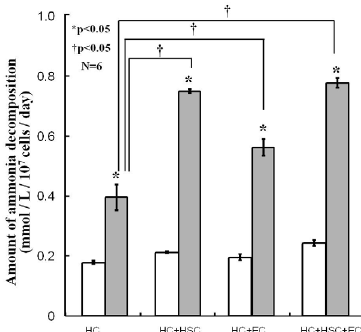
Fig. 4 Amount of ammonia decomposition under flow load. Ammonia decomposition was measured as in Figure 3. White bars, static culture; gray bars, flow load. All models showed significant differences under flow load relative to static culture. Nonparenchymal cells, HSC and EC, influenced ammonia decomposition. The HC+HSC+EC model under flow load showed the highest capacity for ammonia decomposition, relative to all other models both in static culture and under flow load. Data are presented as the means ± SD. *p<0.05 versus HC model in static culture; †p < 0.05 versus HC model under flow load.